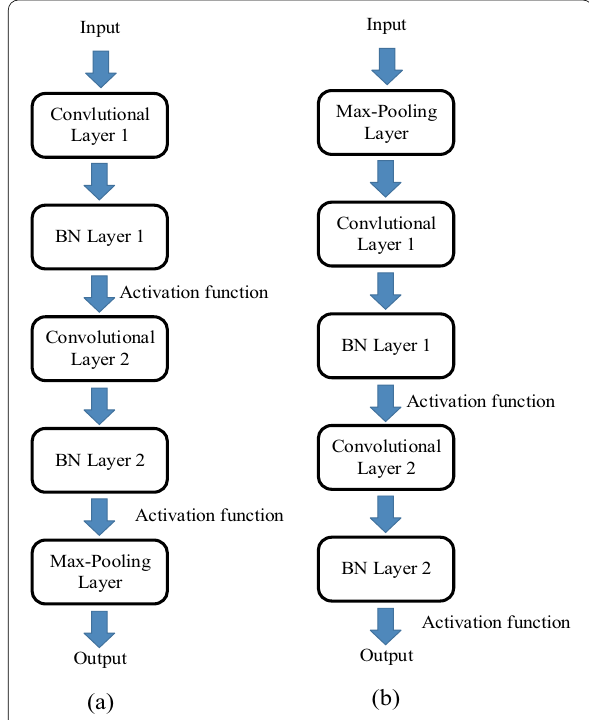
Figure 4 a Structure of five of the six CNN branches, b structure of the sixth CNN